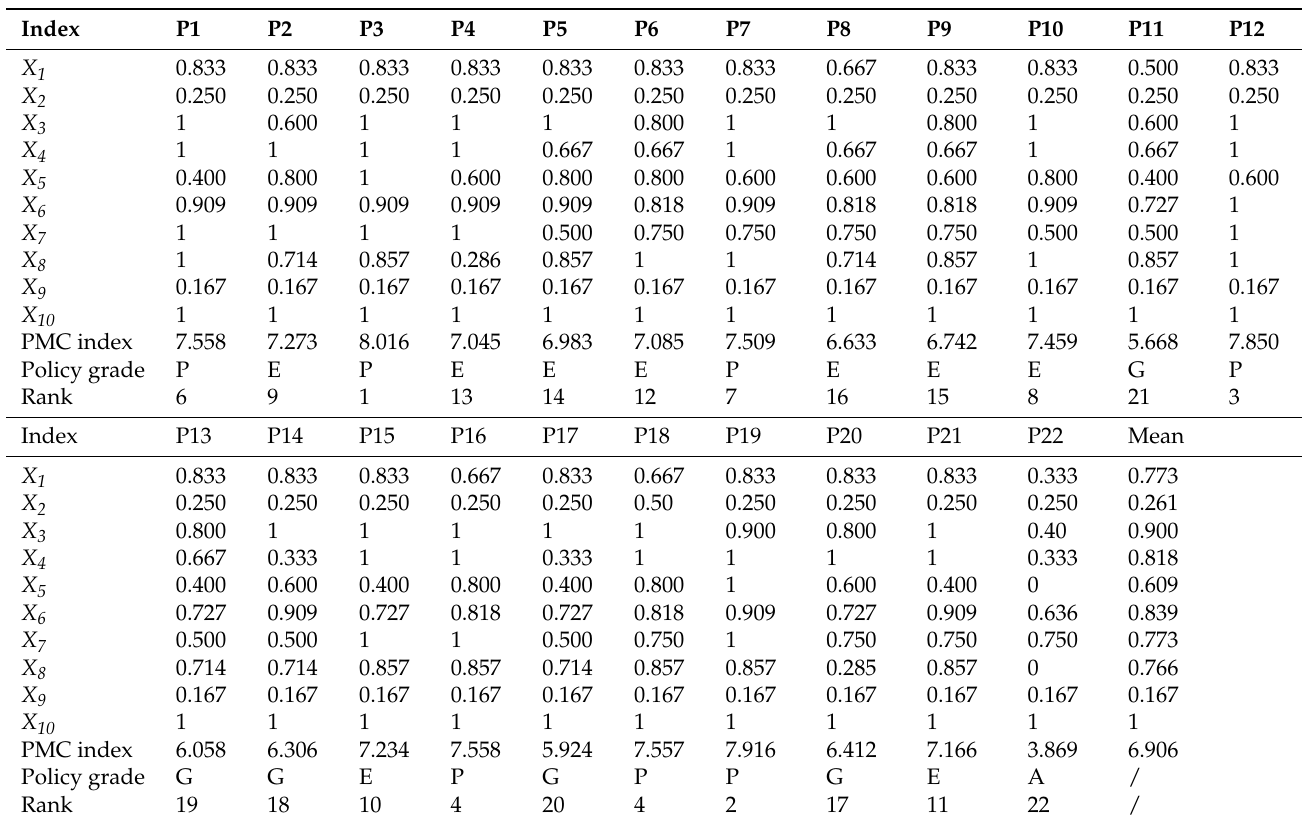
Table 6. PMC indexes and evaluation criteria of all